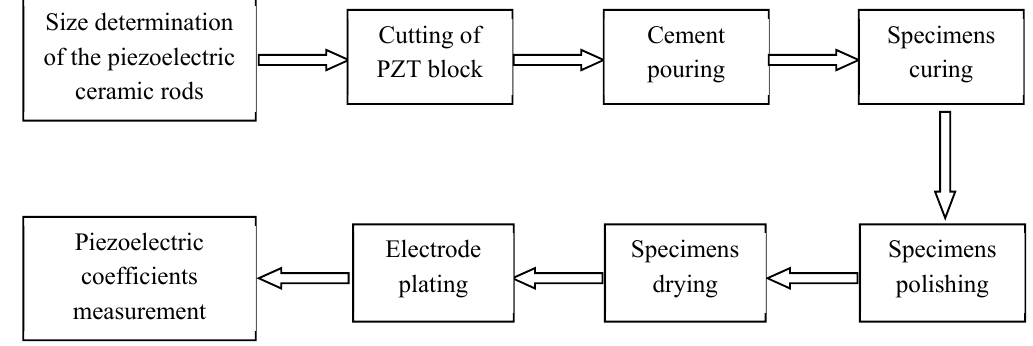
Figure 7. Experiment scheme.